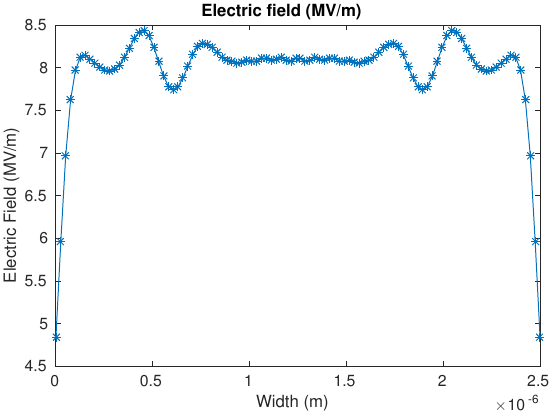
Figure 5. Calculation result of the electric field profile across the beam in the y direction at the mid-length of the beam.